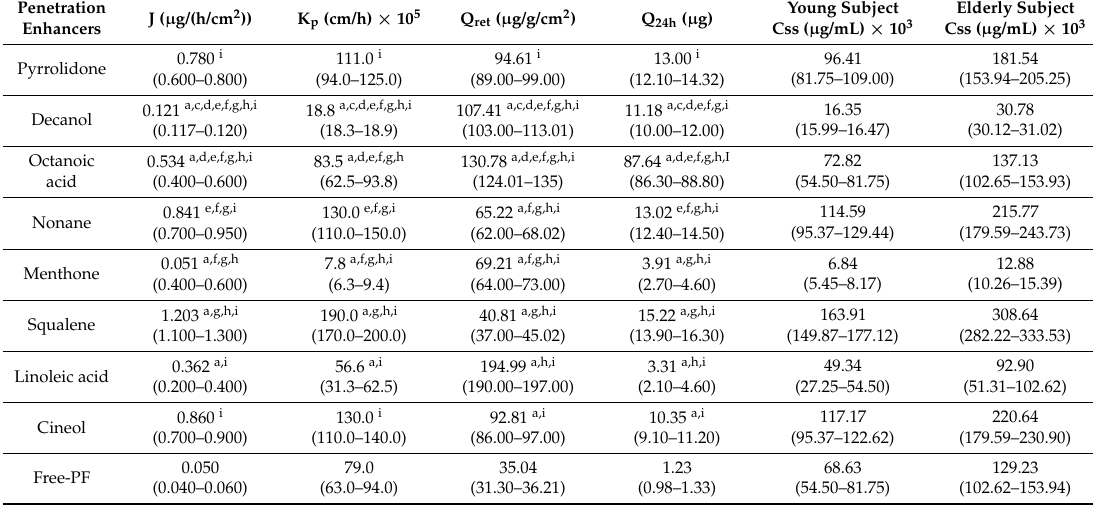
Table 4. Skin permeation parameters of PF in the presence of tested penetration enhancers. Data are represented as median (min-max).